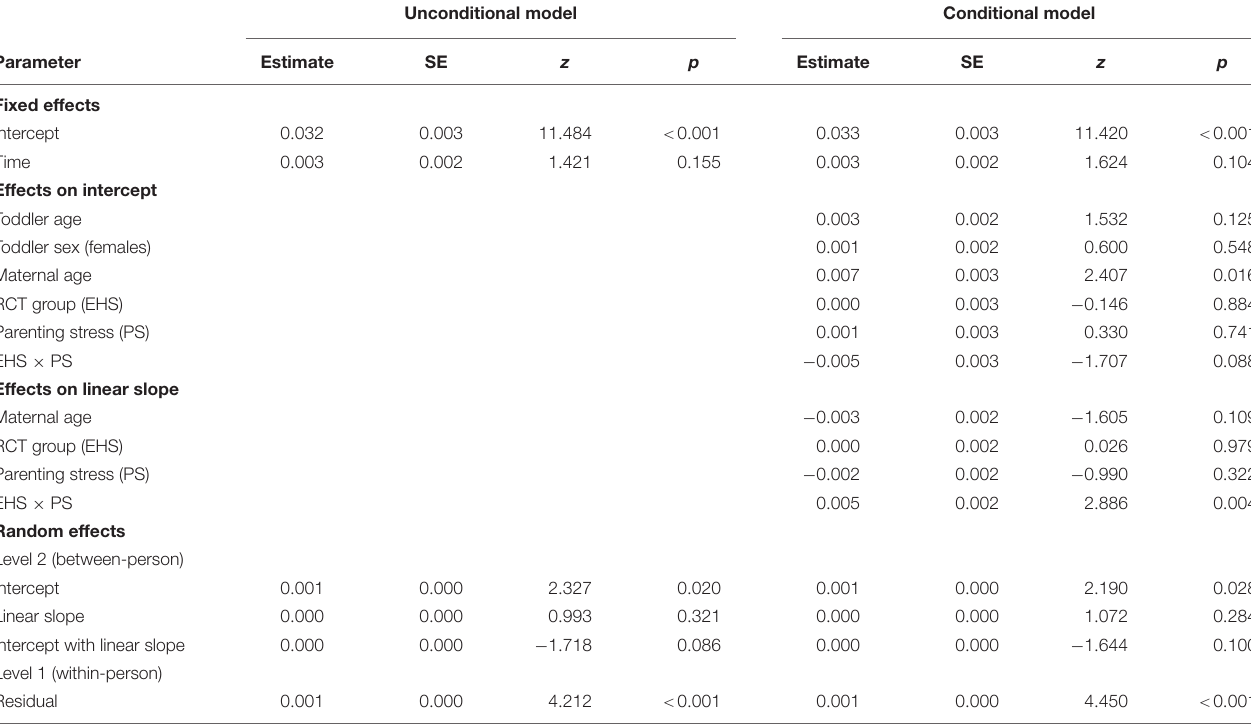
TABLE 3 | Parameter estimates for multilevel models predicting maternal appropriate mind-related